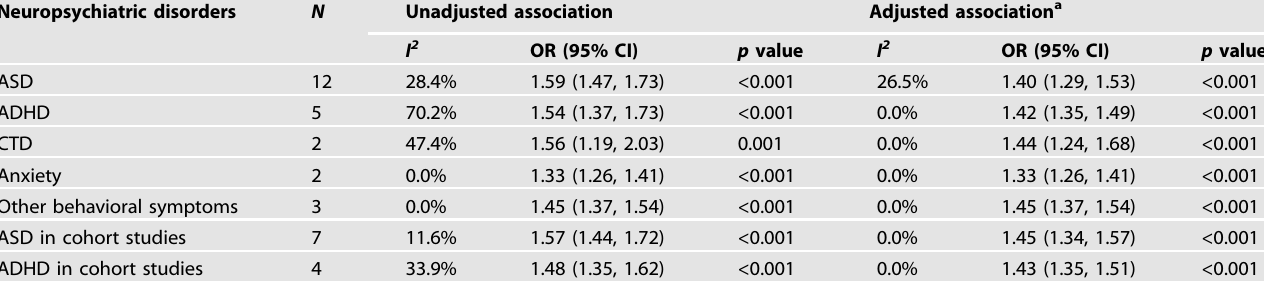
Table 2. Association between maternal PCOS and neuropsychiatric disorders in their children.